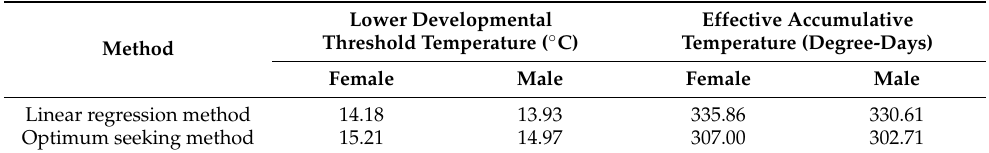
Table 3. Lower developmental threshold temperature and effective accumulative temperature of S. caerulea